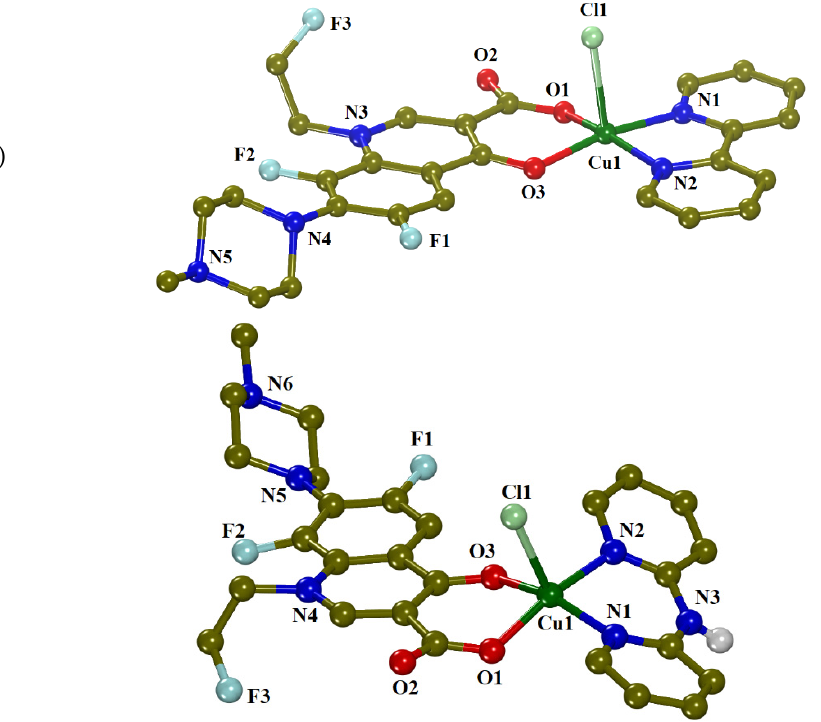
Figure 3. A drawing of the molecular structure of complex ( A ) 6 and ( B ) 7 with only the heteroatom labeling. Hydrogen atoms and solvate molecules are omitted for clarity. Table 2. Selected bond distances, bond angles and structural features for complexes 6 and 7 .